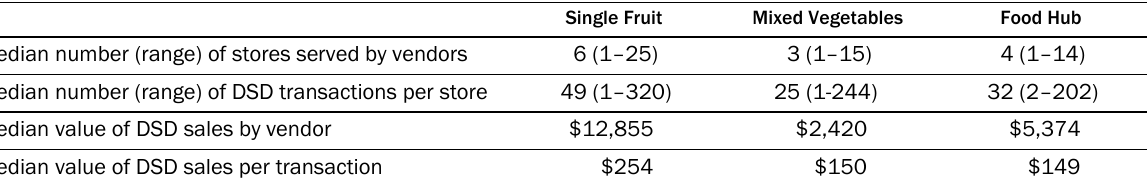
Table 3. Direct-Store-Delivery (DSD) Produce Purchases by Focal Grocery Store by Vendor Type, 2012–2015, January-September (all currency is US$) Single Fruit Mixed Vegetables Food Hub Median number (range) of stores served by vendors Median number (range) of DSD transactions per